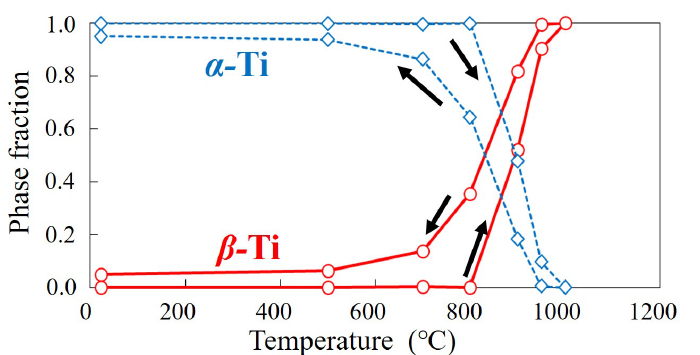
Figure 8. Changes in the phase fraction in volume as a function of temperature analyzed by EBSD